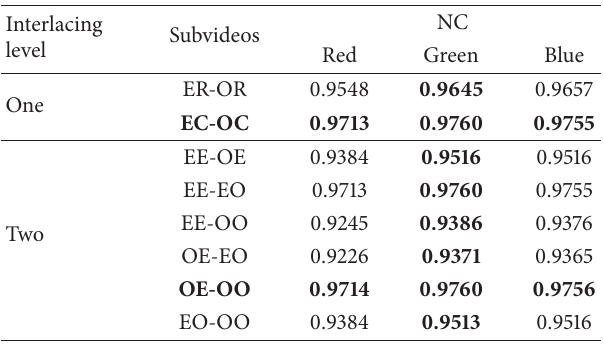
Table 1: Video interlacing